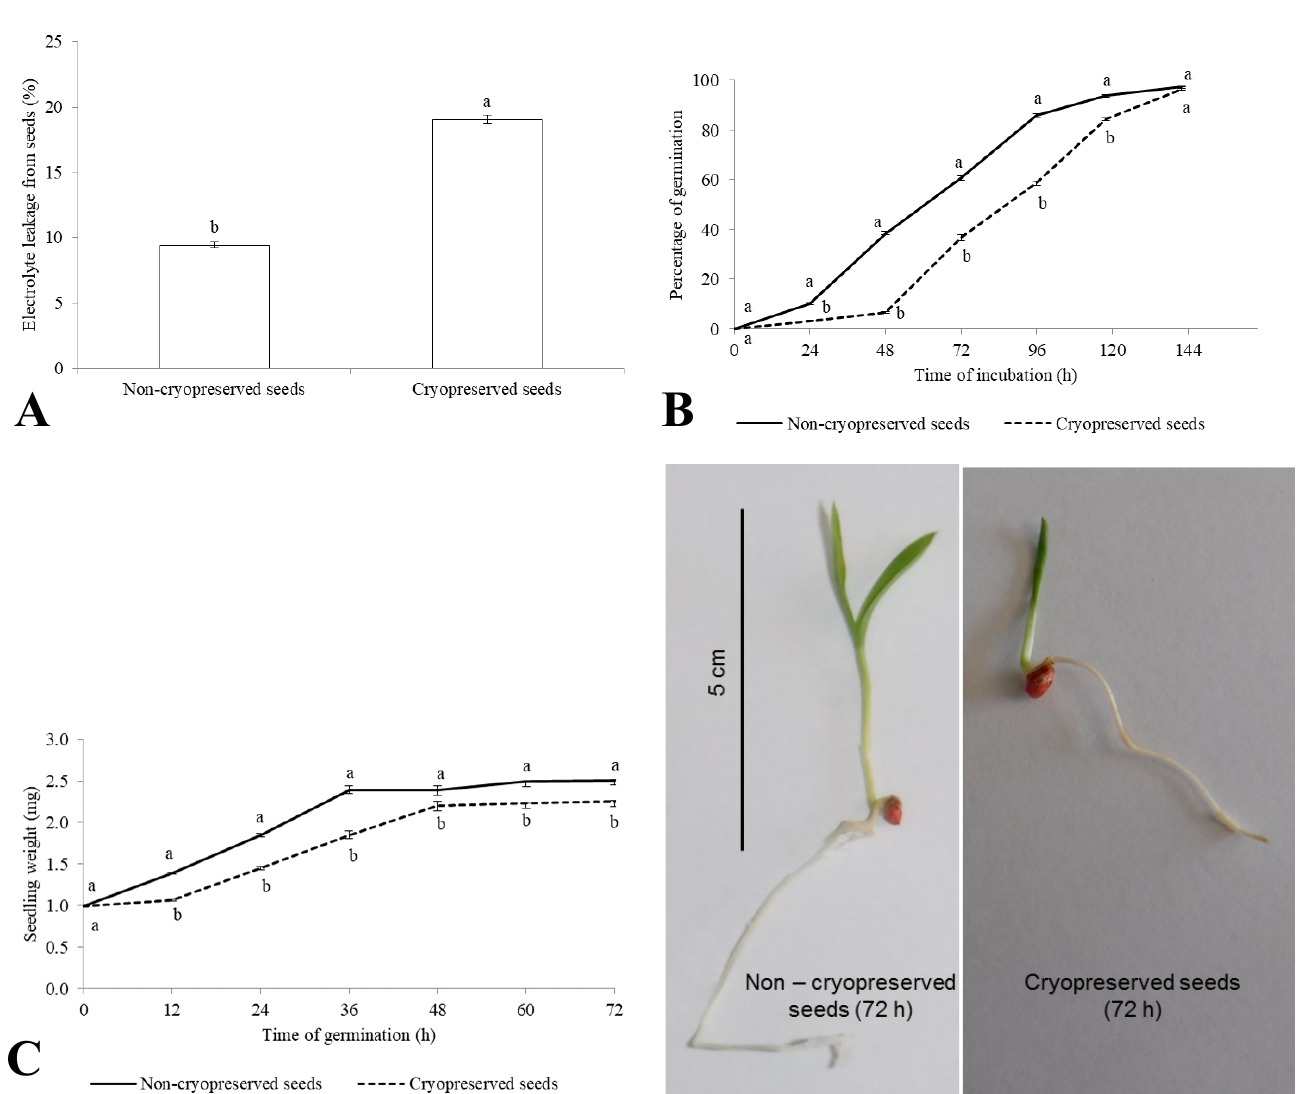
Fig. 2: Effect of seed cryopreservation on seed electrolyte leakage (A), germination (B) and seedling growth (C) from 0 to 144 hours. In each moment of eva- luation, results with the same letters are not statistically different (t-test, p>0,05). Vertical bars represent